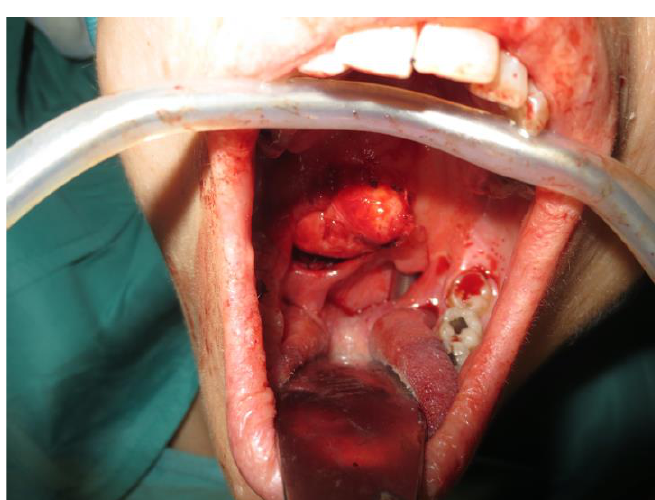
Figure 2. Exposure of the PPS tumour.